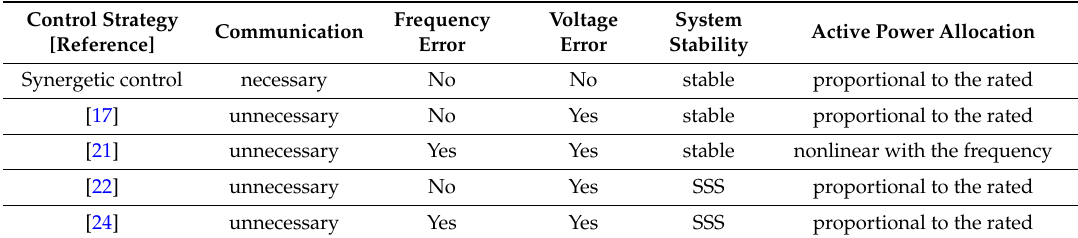
Table 3. Comparison with the improved control